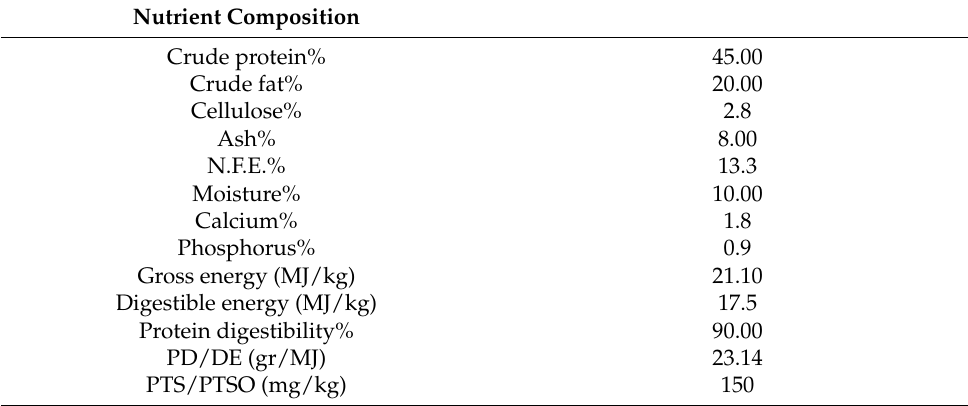
Table 4. Diet composition of the fish experimental